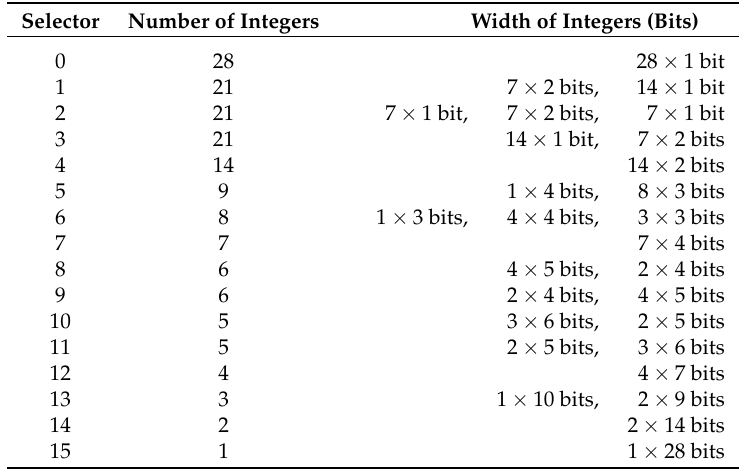
Table 4. Sixteen different ways of encoding numbers in the 28-bit packing space in Simple16. There are no wasted bits in any of the selectors.